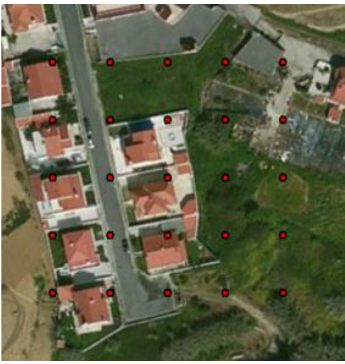
Figure 1: Example of SSUs organised in a 5x5 20m